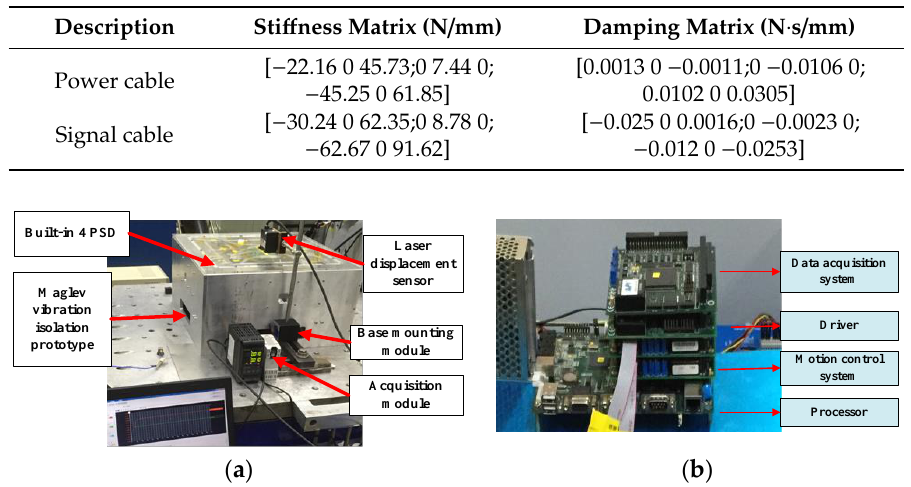
Figure 6. Experimental set-up: ( a ) Prototype and test component; ( b ) hardware of the maglev vibration isolation system.